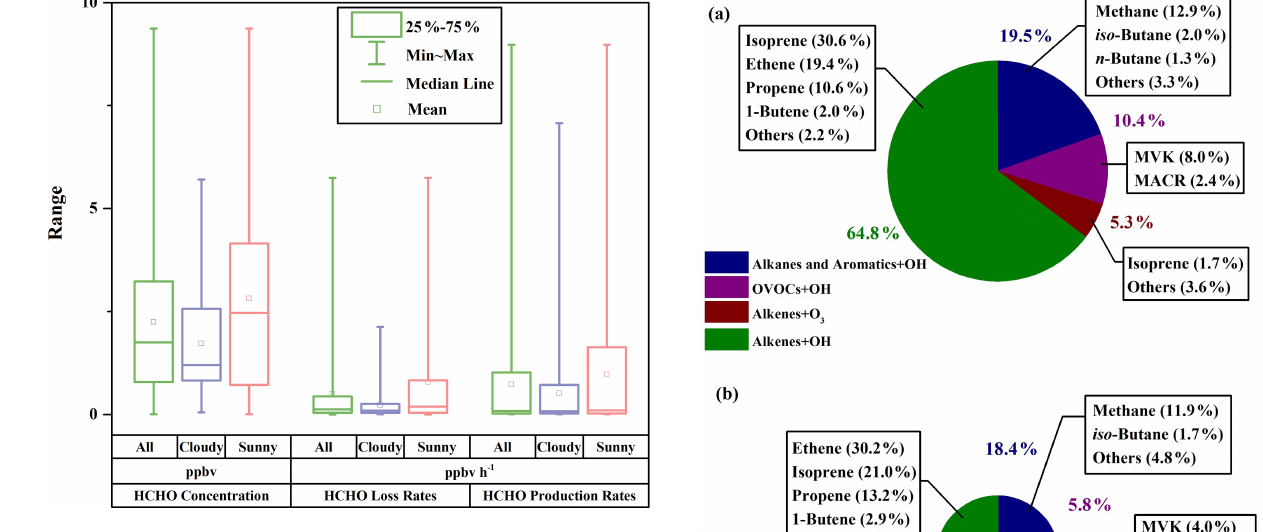
Figure 6. Box plots of HCHO concentration, HCHO loss rates, and HCHO production rates during the whole campaign (All), the cloudy and rainy period (Cloudy), and the sunny period (Sunny). The squares represent the mean; the bands inside the box represent the median; the bottom and top of the box represent the lower and upper quartiles, respectively; and the ends of the whiskers show the minimum and the maximum.